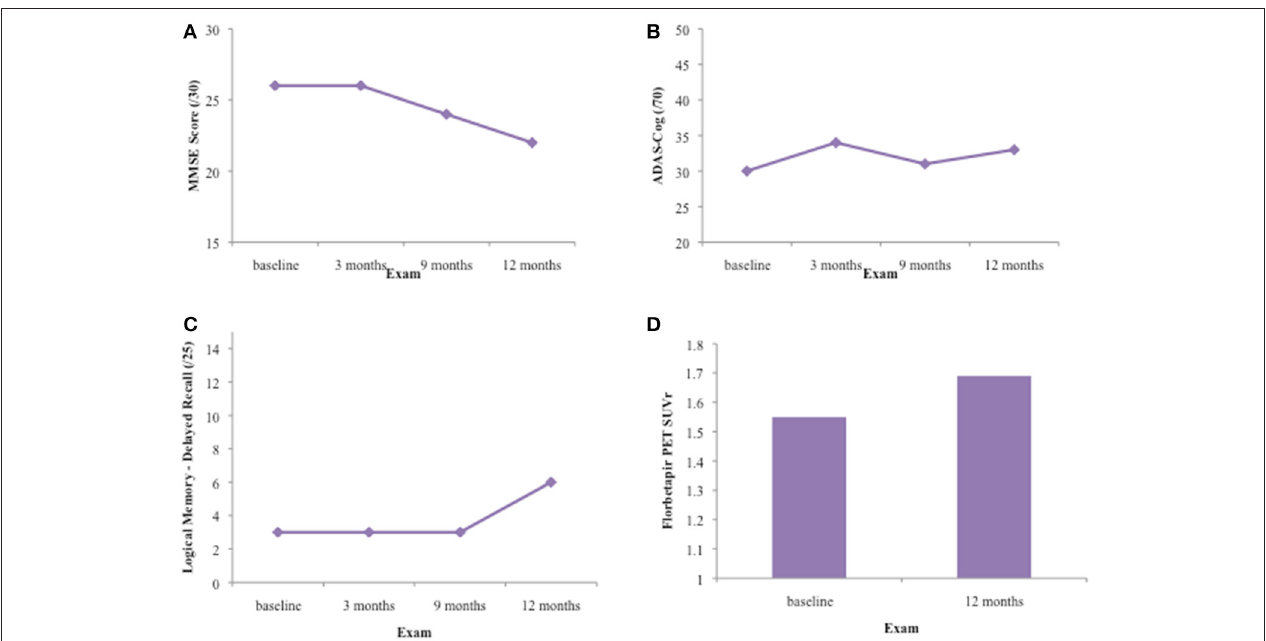
FIGURE 1 | Results on primary outcome measures for patient CS over 12 months of DFMO therapy. (A) Results on the Mini-Mental Status Exam (MMSE)/30 at baseline, 3, 6, and 12 month exams. CS’ MMSE score declined 4 points over the 12 month treatment period, from 26/30 to 22/30, indicating generalized cognitive decline. (B) Results on the Alzheimer’s Disease Assessment Scale-Cognitive Subscale (ADAS-Cog) 11—item at baseline, 3, 6, and 12 month exams. Patient CS’ ADAS-Cog score increased by 3 points over the 12 month treatment period, from 30/70 to 33/70. Higher scores on this test indicate increased cognitive impairment. (C) Results on the delayed recall portion of the Logical Memory stories at baseline, 3, 6, and 12 month exams. The patient showed impaired verbal learning and episodic memory throughout the 12 month treatment period. Although the patient recalled 6/25 items at the 12 month visit, this was not concurrent with results on other episodic memory tests such as the ADAS-Cog word list learning and recall (0/10 words at delayed recall) and the ISLT (2/12 shopping items at delayed recall). (D) SUVr on Florbetapir PET scan at baseline (1.55) and after 12 month treatment period